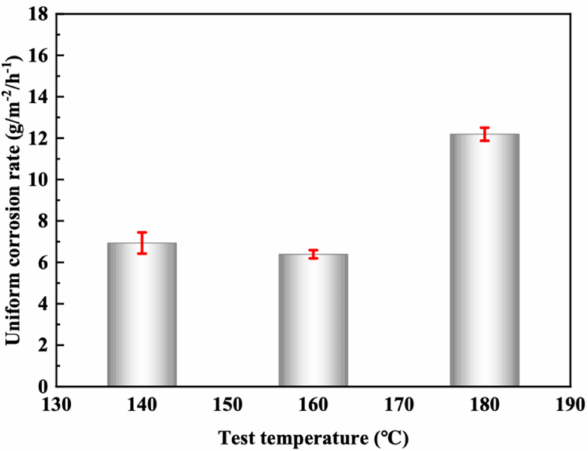
Figure 5. Uniform corrosion rate of 2205 duplex stainless steel at different temperatures.